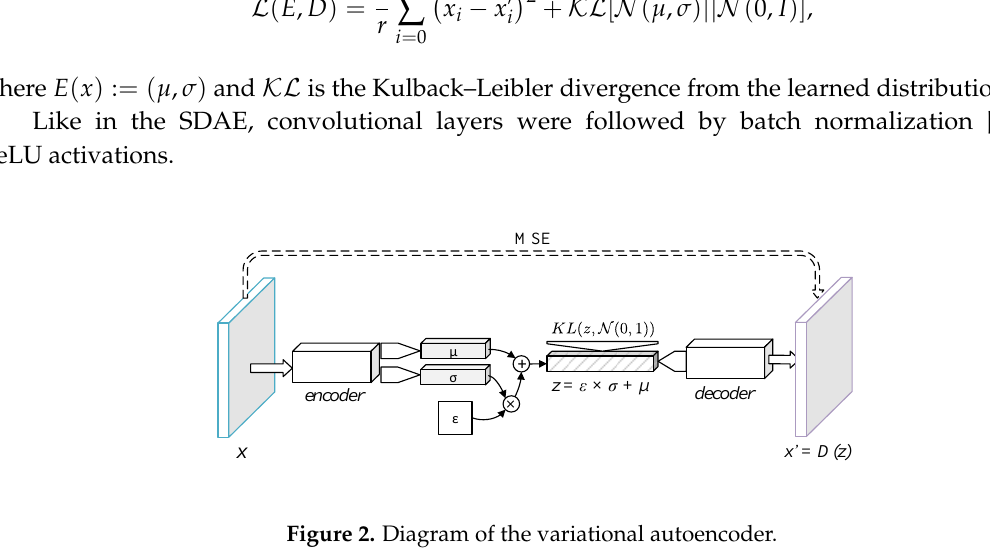
Figure 2. Diagram of the variational